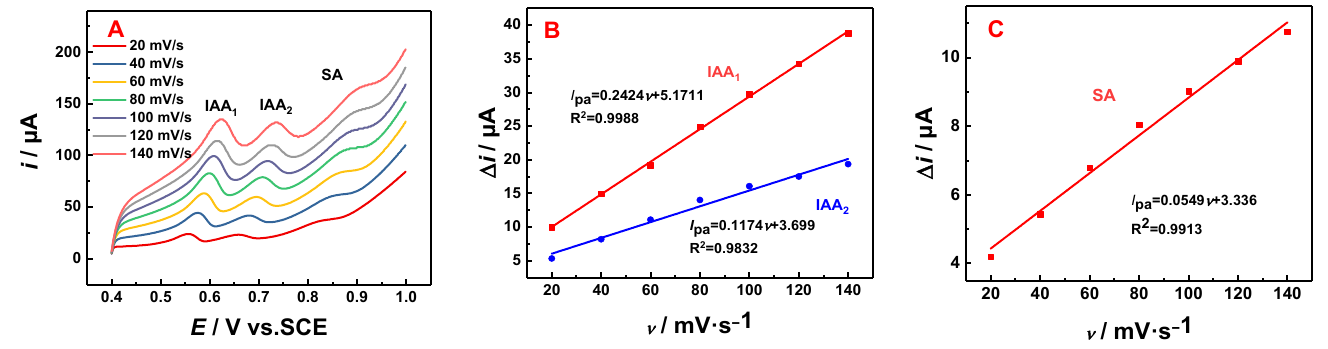
Figure 6. ( A ) LSV curves of CuNPs-CSF-CNPs-MWCNTs/GCE in PBS (pH = 7) containing 50 μ M IAA and 50 μ M SA at different scan rates. ( B ) The linear correlation curve of peak current of IAA 1 and IAA 2 vs. the scan rates, respectively. ( C ) The linear correlation curve of peak current of SA vs. the scan rates.